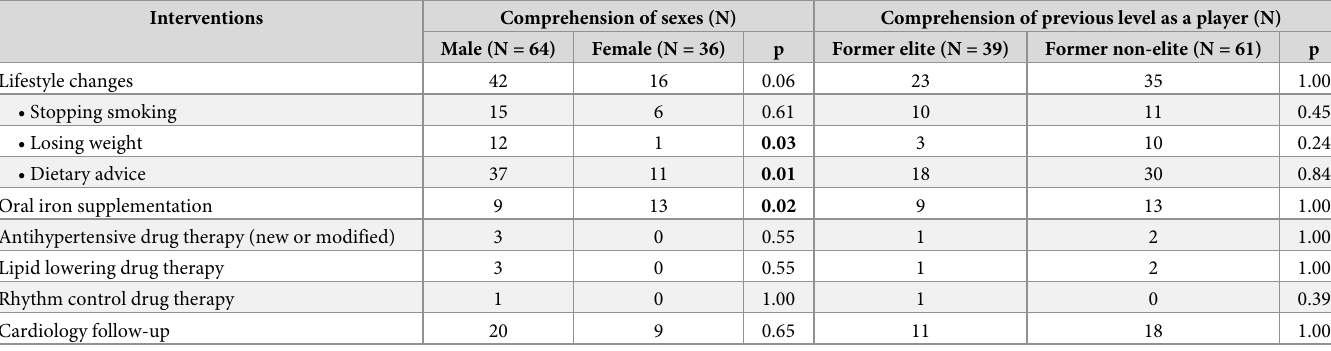
Interventions Lifestyle changes were advised to 58.0% of the referees, including quitting smoking, losing weight, and introducing dietary changes (Table 3). New antihypertensive drug therapy was offered in 2 cases, antihypertensive drug therapy modification in 1 case, regular blood pressure monitorization in 12 cases. Lipid-lowering therapy was started in three male patients because of elevated lipid levels in all cases and also a non-significant coronary artery disease in one case. Beta-blocker therapy was initialized in one patient for the treatment of frequent PVCs. Oral iron supplementary therapies and control blood testing were suggested in 22.0% (male: Table 3. Number of interventions indicated by the extended cardiology screening of handball referees. Interventions Comprehension of sexes (N) Comprehension of previous level as a player (N) Male (N = 64) Female (N = 36) p Former elite (N = 39) Former non-elite (N = 61) Lifestyle changes 42 1.00